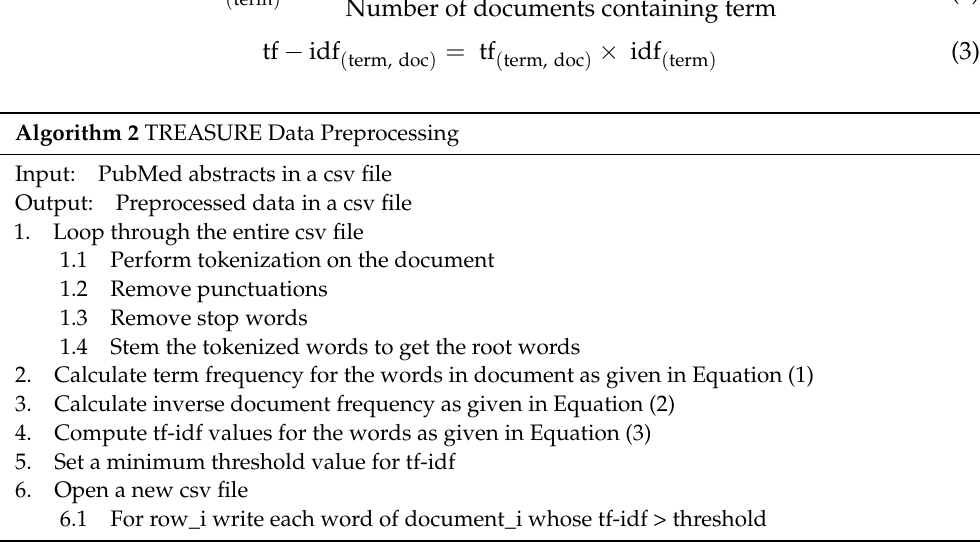
Algorithm 2 TREASURE Data